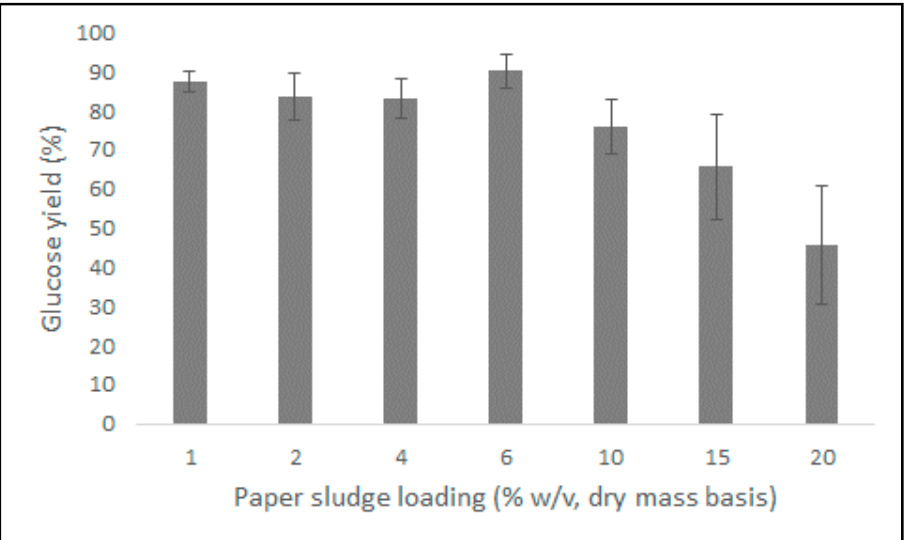
Figure 6. Glucose yield obtained by the action of the formulated cellulase cocktail at 15 mg/g biomass with BGL at 10% protein loading during the hydrolysis of varying substrate loadings (1 to 20% ( w / v )) paper sludge at 50 °C for 48 h. All experiments were performed in quadruplicate, and the mean values and error bars (±SD) were calculated. The statistical analysis showed that the differences were statistically significant (one-way ANOVA, p < 0.05).